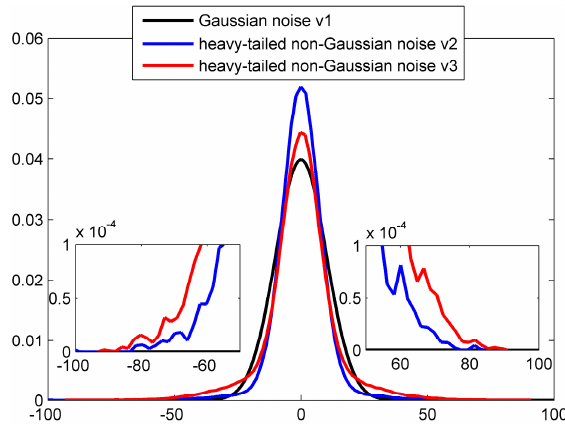
Figure 1. Gaussian distribution and heavy tailed non-Gaussian distribution induced by outlier interference.